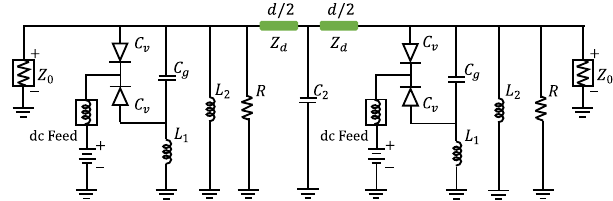
FIG. 18. Extracted circuit model of the designed birefringent board for the parallel